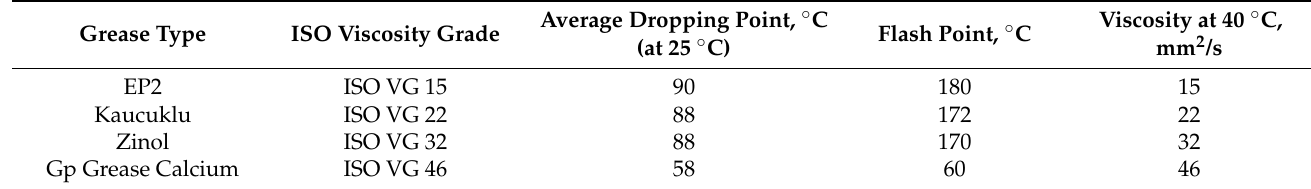
Figure 4. Different types of grease: ( a ) EP2, ( b ) Kaucuklu, ( c ) Zinol, ( d ) Gp Grease Calcium . Table 3. Selected properties of the greases used.